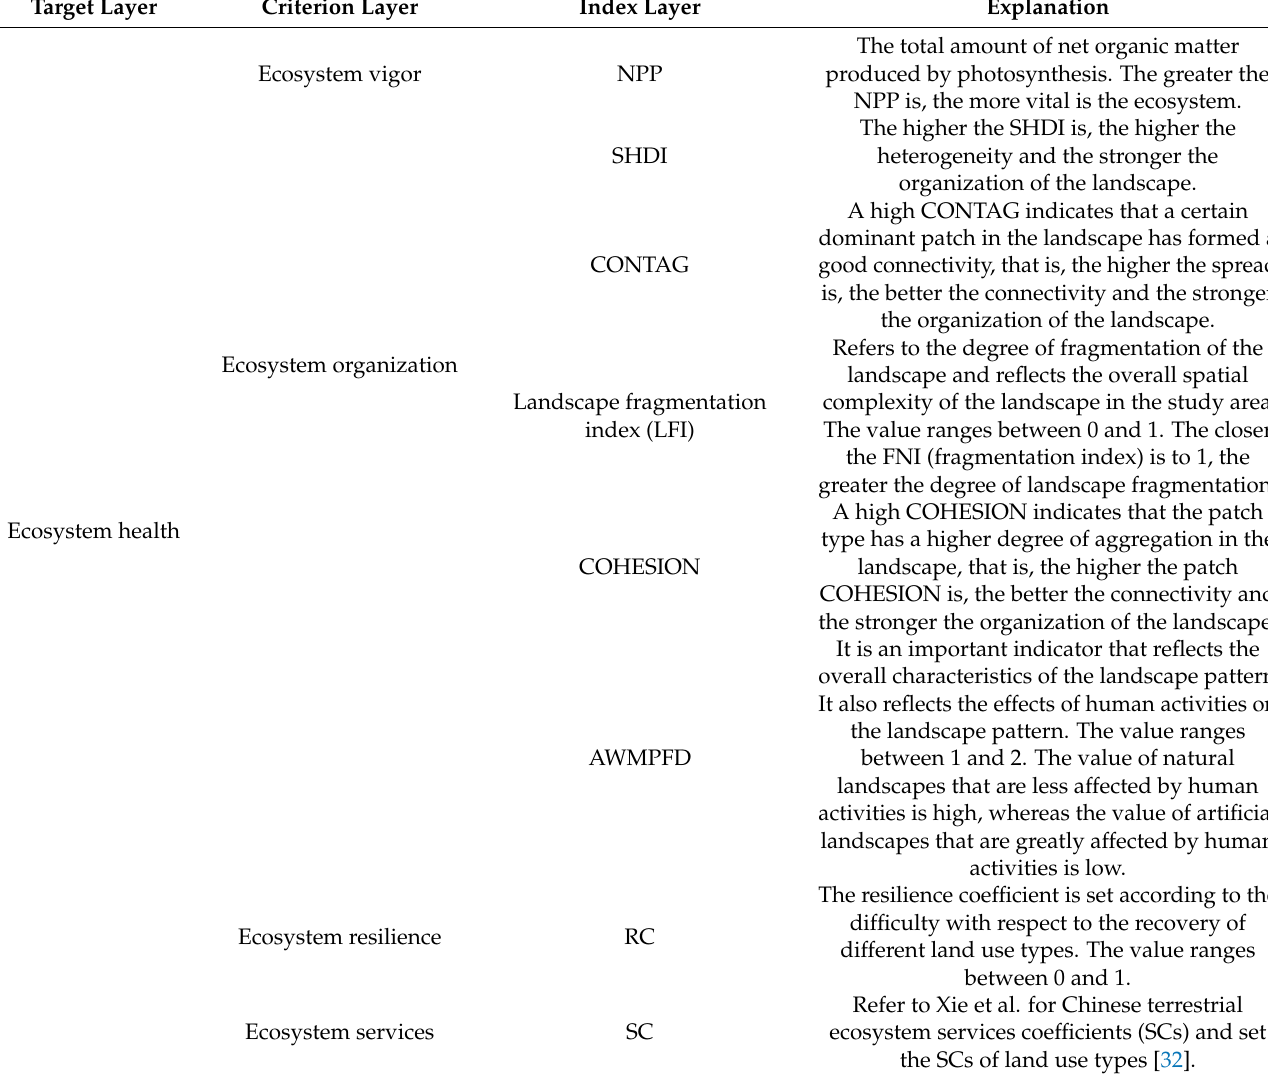
Table 2. Index system of urban ecosystem health assessment based on the VORS